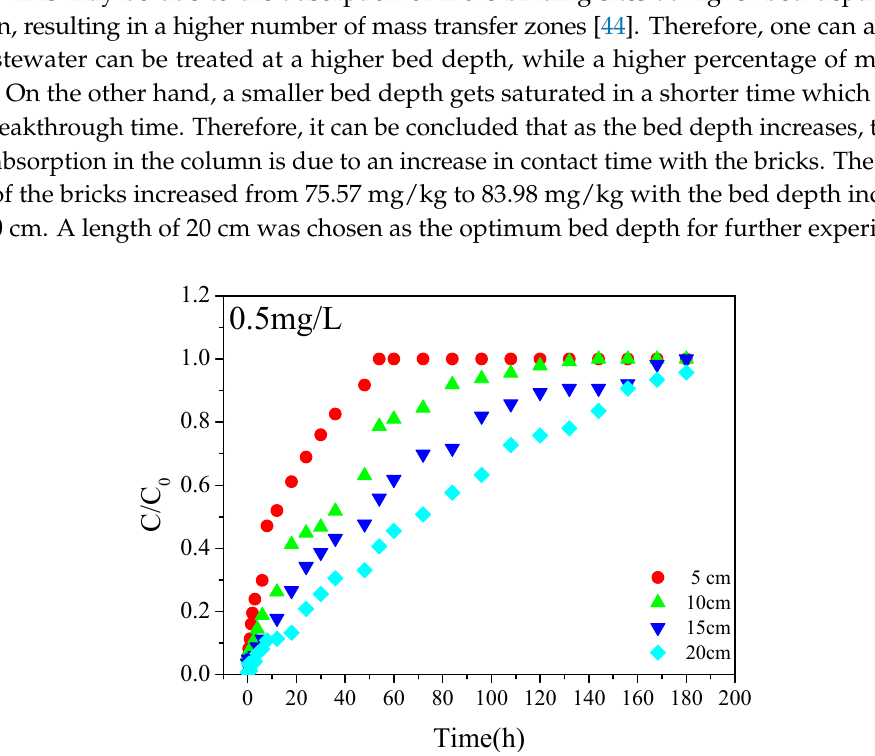
Figure 7. The breakthrough curve for varying bed depth (cm) at a residence time of 10 min and 0.5 mg/L inlet Cu(II) concentration.